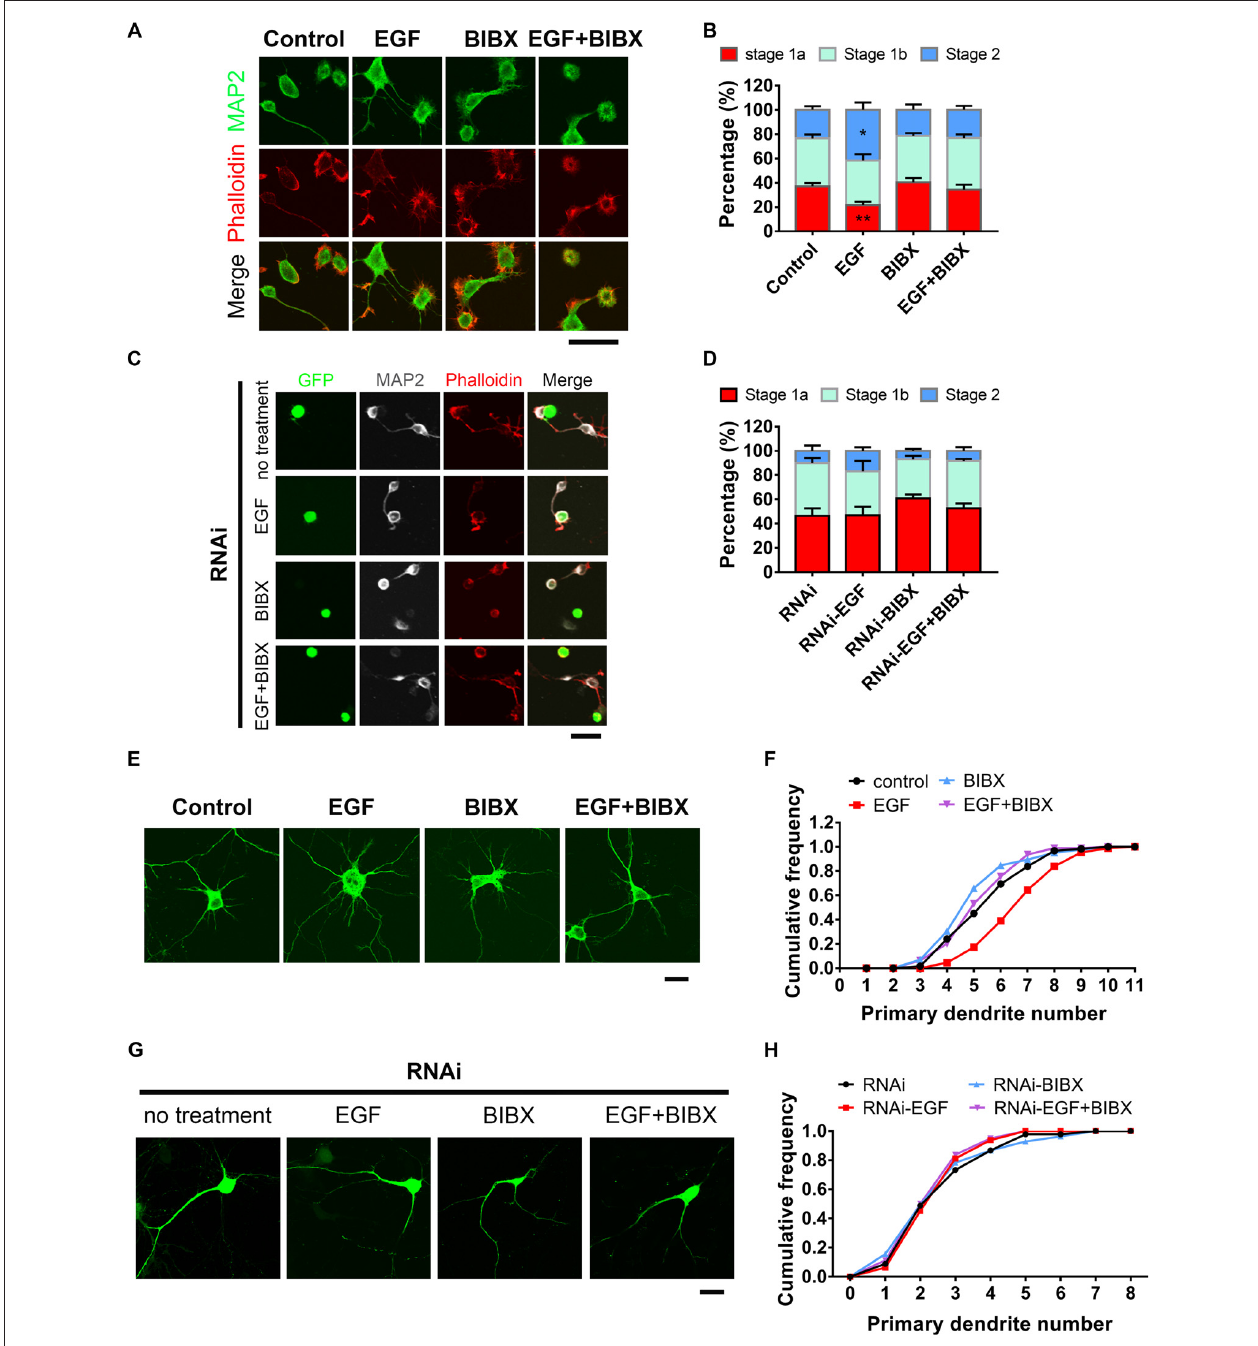
FIGURE 3 | HIP1R is necessary for epidermal growth factor (EGF) induced-acceleration of neurite initiation and dendrite arbor growth. (A) Representative images of DIV 0 neurons treated with EGF (50 ng/ml), BIBX (0.5 µ M) or EGF+BIBX and labeled for MAP2 (green), pallolidin (red), harvested 4–5 h after plating. Scale bar, 20 µ m. (B) Quantification of neurite initiation after EGF treatment ( n = 4,100 neurons for Control, 4,372 neurons for EGF, 5,003 neurons for BIBX and 3,913 neurons for EGF+BIBX treated neurons; ≥ 3 independent cultures; unpaired two-tailed t -test). (C,D) Representative images (C) and neurite initiation stage quantification (D) of HIP1R-RNAi neurons EGF, BIBX or EGF+BIBX, harvested 5–6 h after plating ( n = 1,419 neurons for RNAi, 1,040 neurons for EGF, 1,642 neurons for BIBX and 1,368 neurons for EGF+ BIBX treated neurons; three independent cultures; unpaired two-tailed t -test). Scale bar, 20 µ m. (E) Representative images of DIV 6 neurons treated with EGF, BIBX or EGF+BIBX. Scale bar, 20 µ m. (F) Cumulative distribution of primary dendritic numbers of control, EGF, BIBX or EGF+BIBX treated groups ( n = 62, 87, 85 and 94, respectively; three independent cultures). (G) Representative images of HIP1R-RNAi neurons without treatment and treated with EGF, BIBX or EGF+BIBX at DIV 6. Scale bar, 20 µ m. (H) Cumulative distribution of primary dendritic numbers of HIP1R-RNAi neurons with or without treatment ( n = 64, 64, 83 and 80, respectively; three independent cultures). All data are presented as mean ± SEM; ∗ p < 0.05; ∗∗ p < 0.01.